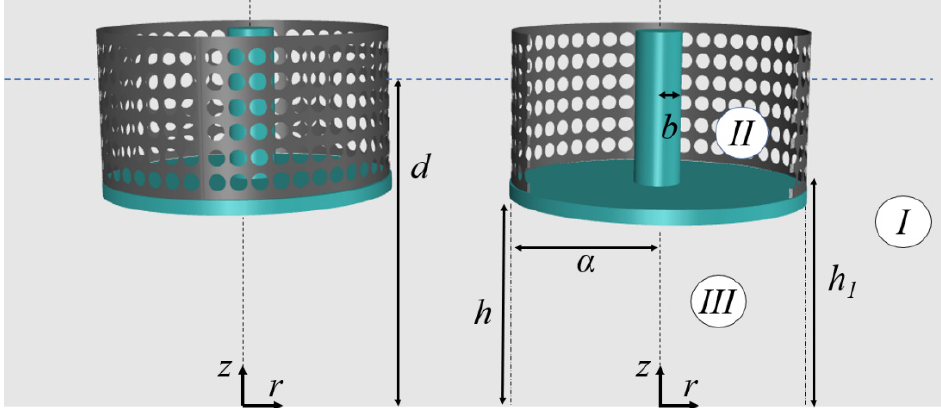
Figure 1. 3D representation of the examined porous compound cylindrical body.